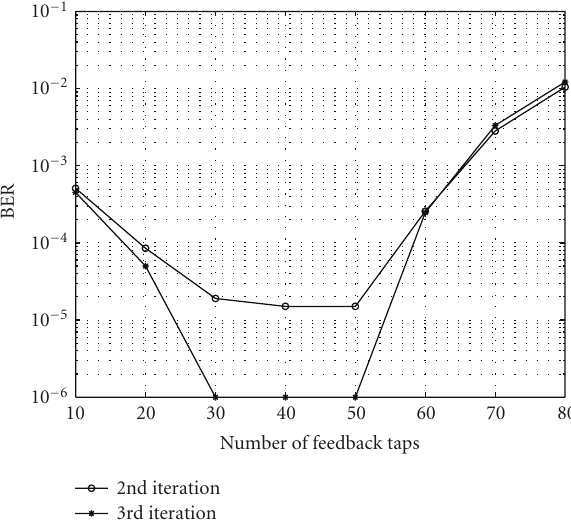
Figure 10: Performance of proposed iterative receiver for varying number of feedback